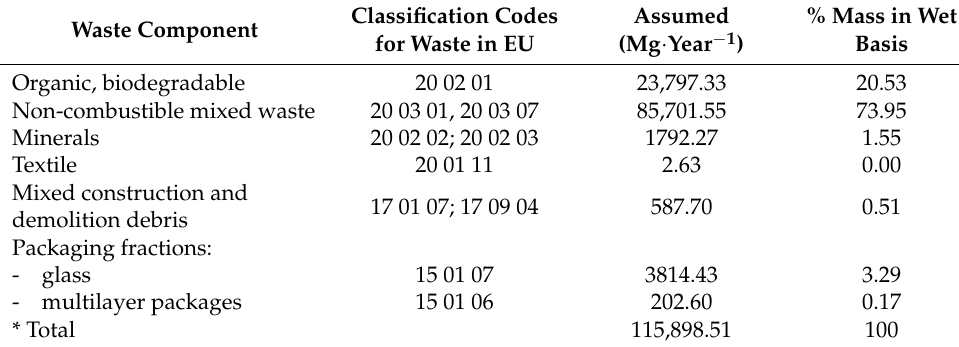
Table 1. Amount and composition of waste in the municipal waste landfill site collected in 2017, according to the survey in